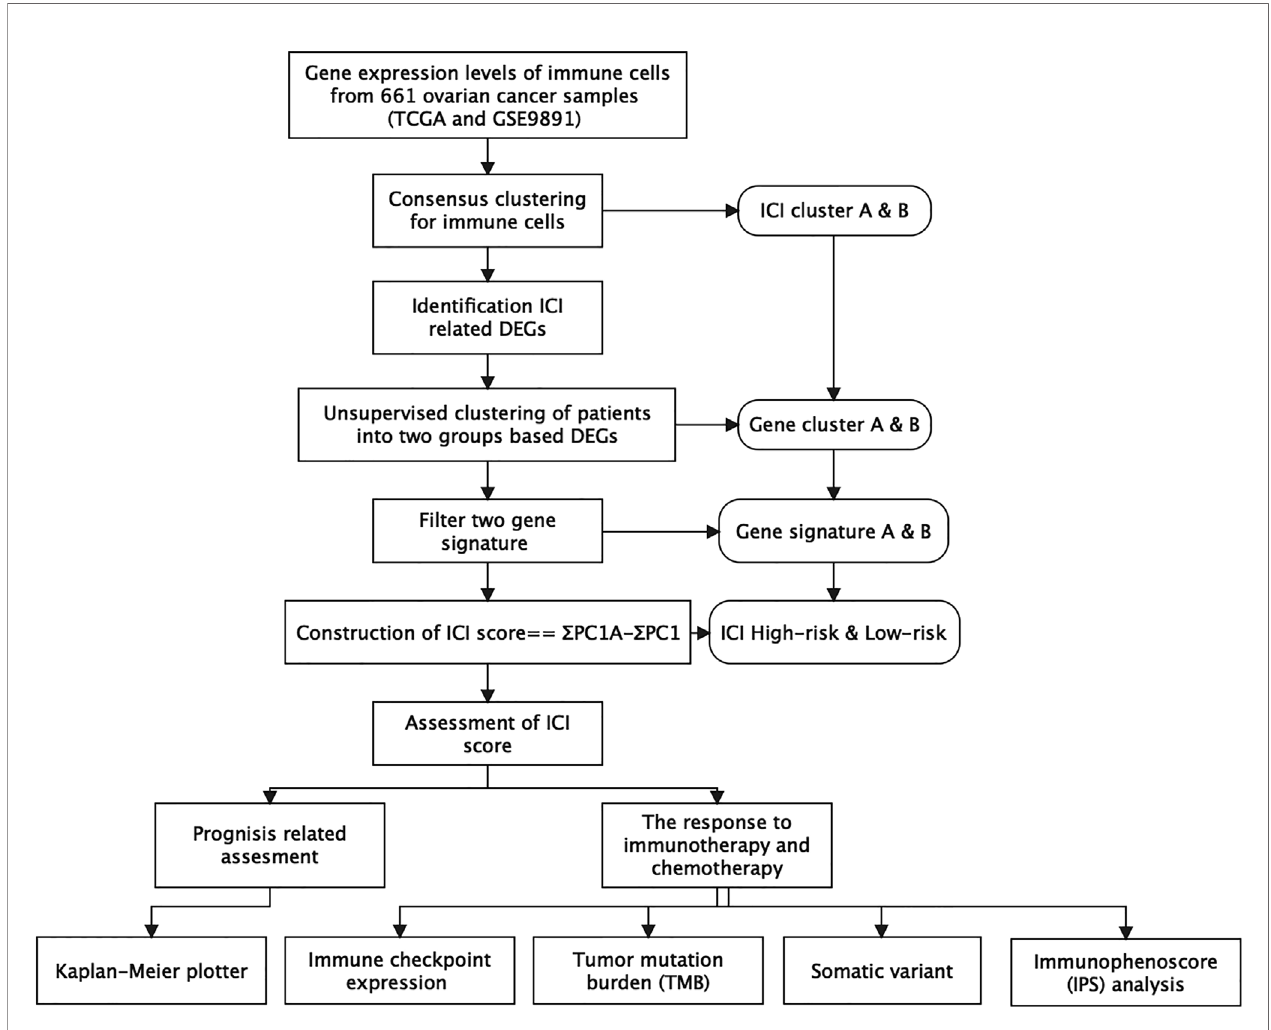
FIGURE 1 | The brief work fl ow of this